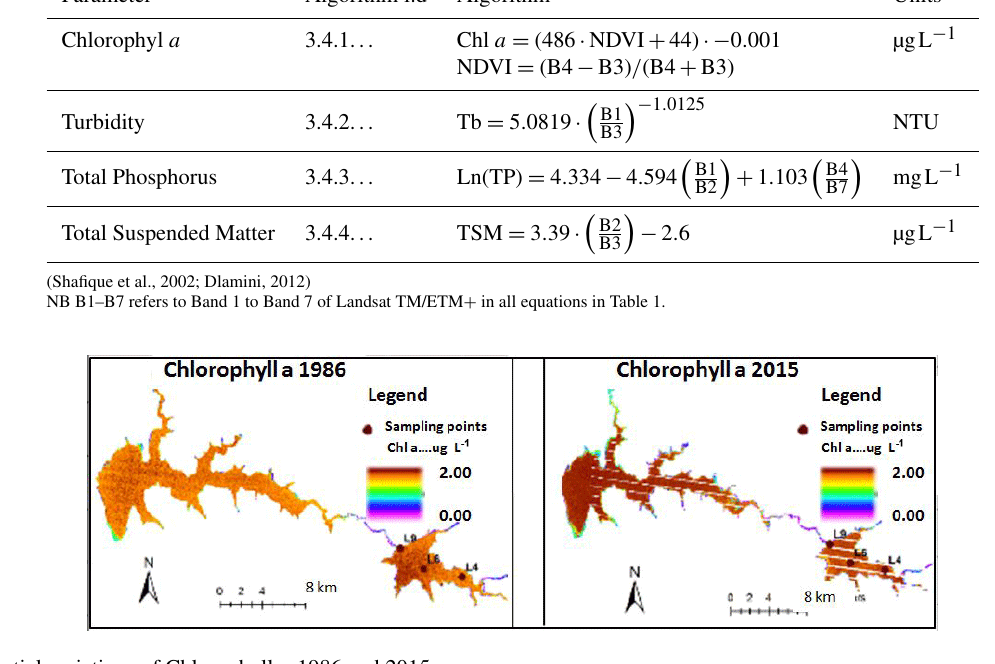
Figure 2. Spatial variations of Chlorophyll a 1986 and 2015.